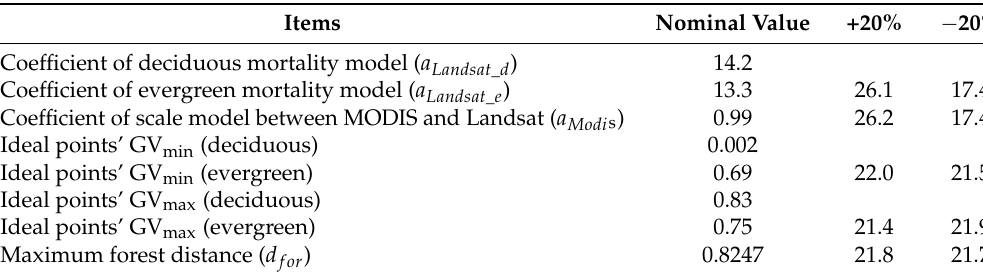
Table 2. The sensitivity analysis of the simulation: the biomass loss (Tg) output by changing the value of coefficients and parameters in ± 20%.